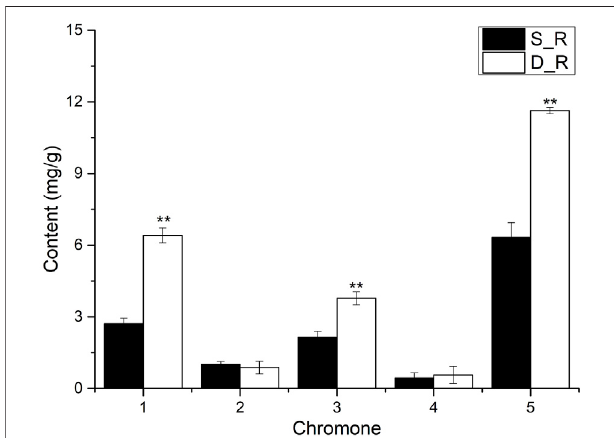
FIGURE 3 | Results of chromone content in single-headed roots and double-headed roots. Note:1): prim- O -glucosylcimifugin; 2): 4 ′ - O - β -D- glucosyl-5- O -methylvisamminol; 3): cimifugin; 4): sec- O -glucosylhamaudol; 5): Total chromone. * p < 0.05. ** p < 0.01, compared with control group. Vertical bars indicate the mean value ± standard deviation from three independent experiments. The same